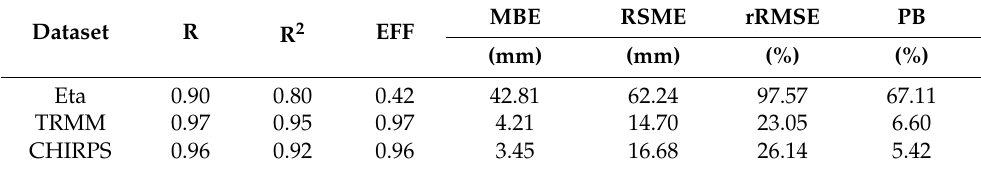
Table 4. Coefficients of correlation (R), of determination (R 2 ), and of Nash-Sutcliffe efficiency (EFF),